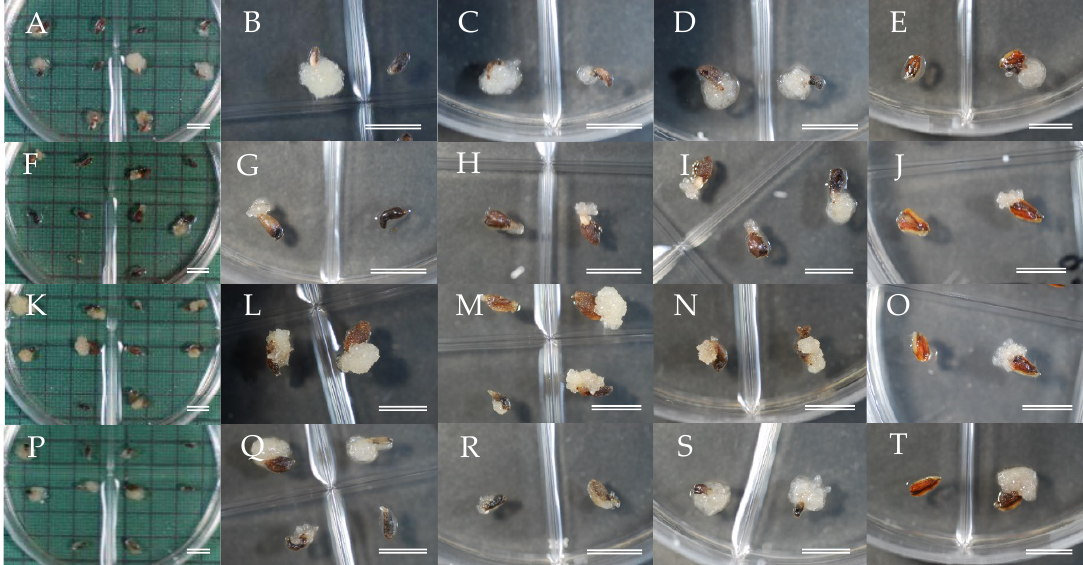
Figure 1. Somatic embryogenesis (SE) initiation from different seed families, ( A – E ) lines from ‘Shindai 3’ × ’Suzu 2’ family, ( F – J ) lines from ‘Fukushima-funen 1’ × ’S3-37(1)’ family, ( K – O ) lines from ‘Fukushima-funen 1’ × ’Oi 7’ family, ( P – T ) lines from ‘Fukushima-funen 1’ × ’S3-118(2)’ family. Bars 1 cm. Table 1. SE initiation frequency of sugi seed families carrying the male sterility gene MS1 . Data represent the explants with SE initiation response/total number of explants tested; and the numbers in the parentheses represent the initiation frequency (%) for each family at four different seed collection dates.